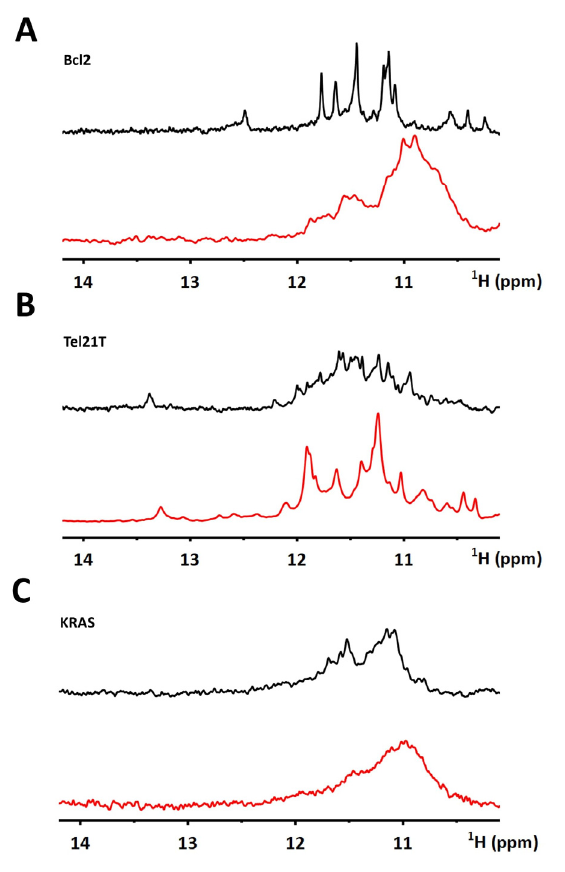
Figure 1. Imino regions of 1D 1 H NMR spectra of Bcl2 ( A ), Tel21T ( B ), and KRAS ( C ), acquired in EC buffer in the absence (black) and the presence (red) of BRACO19. The spectra were measured at 20 °C. 1:2 DNA to ligand ratio was used for Bcl2, and 1:1 ratio for Tel21T and KRAS.